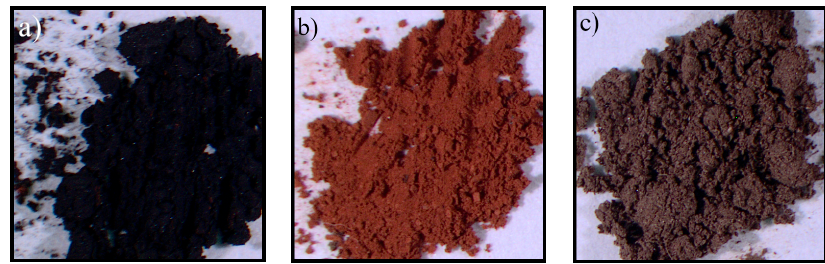
Figure 2. ( a ) Milled Ecuadorian BMS, ( b ) P-180 and ( c ) 180 powders.